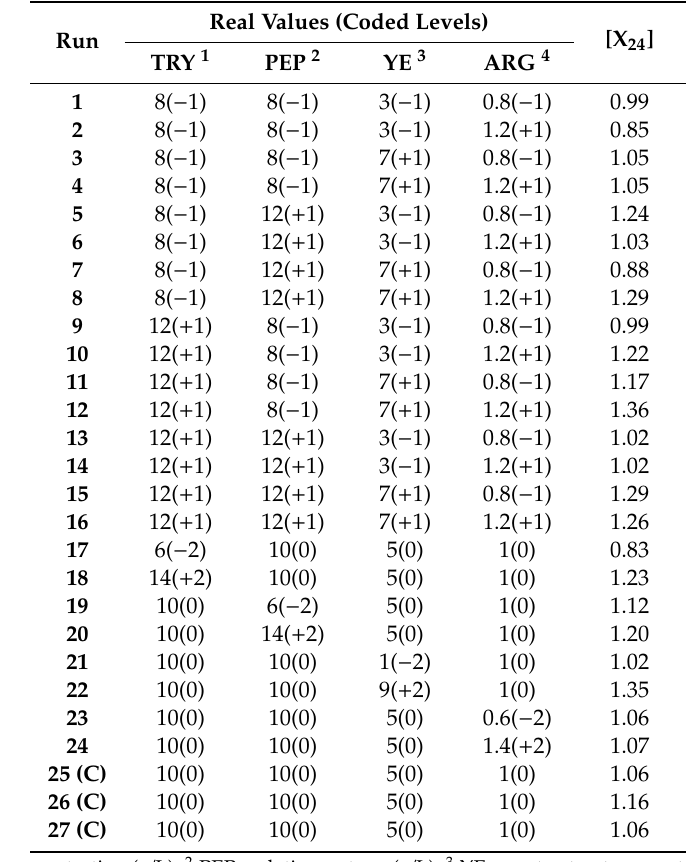
Table 3. Central composite rotational design (CCRD) matrix with real and coded values and